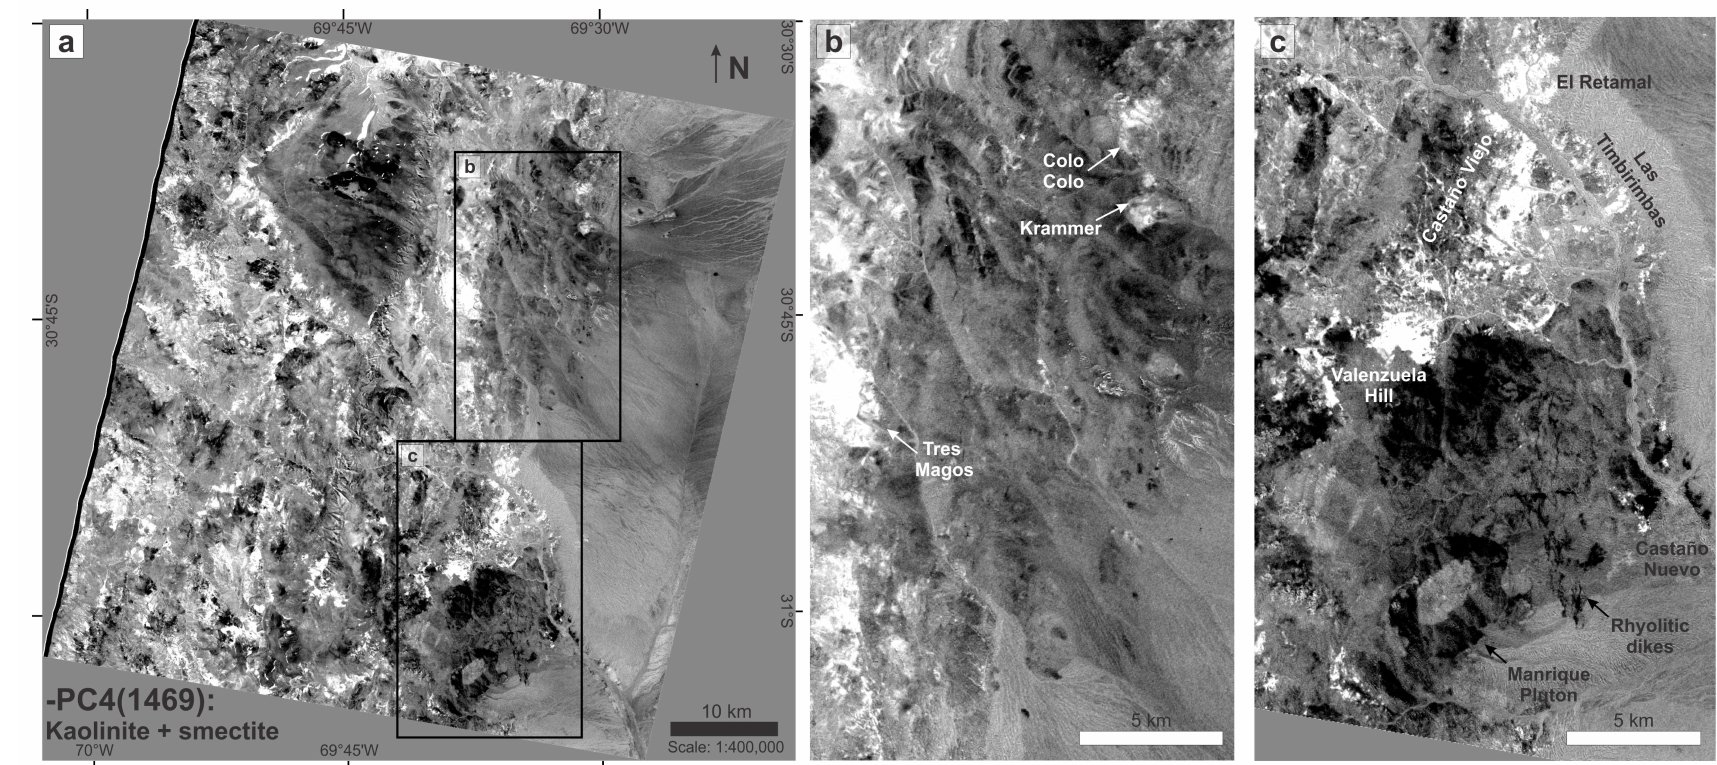
Figure A6. ( a ) Grey-scale image yielded by the negated principal component 4 for bands 1, 4, 6 and 9 (kaolinite and smectite). The white zones represent areas where it is more likely to find kaolinite and smectite ( ± phyllosilicates). ( b ) In the northern portion of the ASTER scene the hydrothermal alteration associated to Tres Magos, Krammer and Colo-Colo are highlighted. ( c ) In the southern portion of the ASTER scene the hydrothermal alteration associated to the NNE-trending Castaño Viejo alteration zone (from Valenzuela Hill to El Retamal and Las Timbirimbas), and the more restricted Castaño Nuevo alteration zone are detected. The silicic-altered areas at Castaño Nuevo, silica-rich facies at Valenzuela Hill, the Manrique Pluton and rhyolitic dykes are highlighted in black to dark